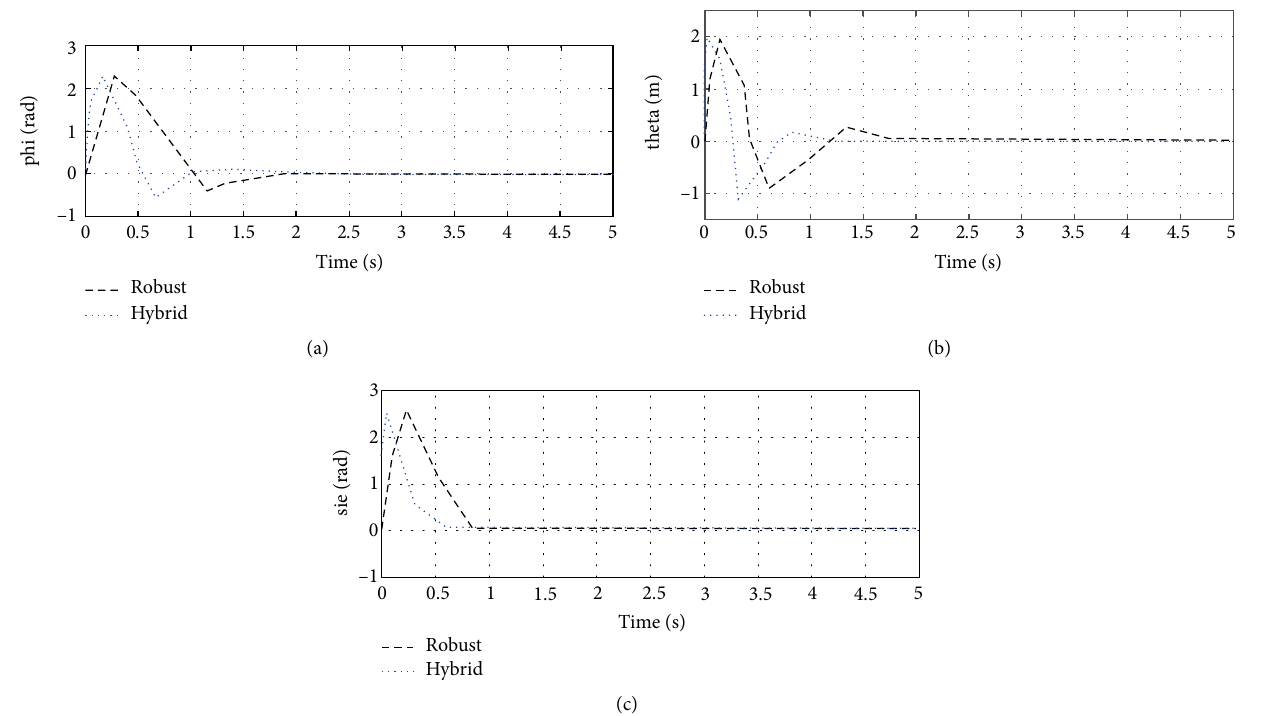
Figure 5: (a) The Euler angles phi of UAV. (b) The Euler angles theta of UAV. (c) The Euler angle sie of